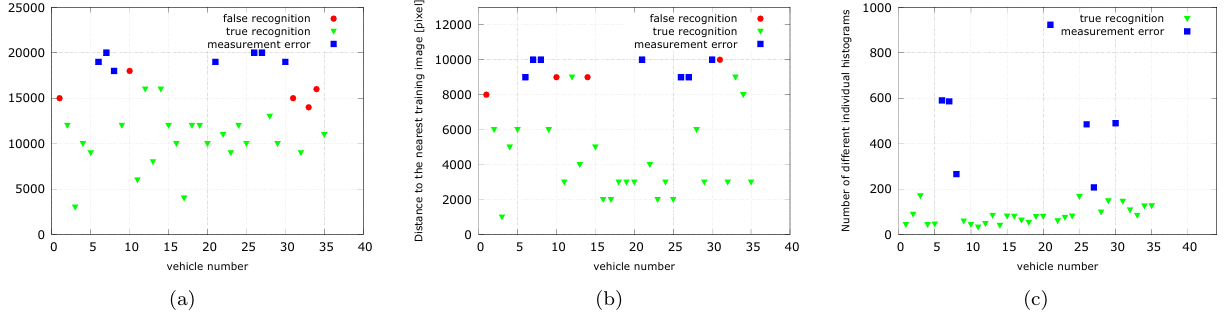
Figure 13: Distance between the query image and the next nearest training image - (a) Eigenfaces, (b) Fisherfaces and (c) local binary patterns histograms (LBPH) faces, Fisherfaces and local binary pattern histograms).